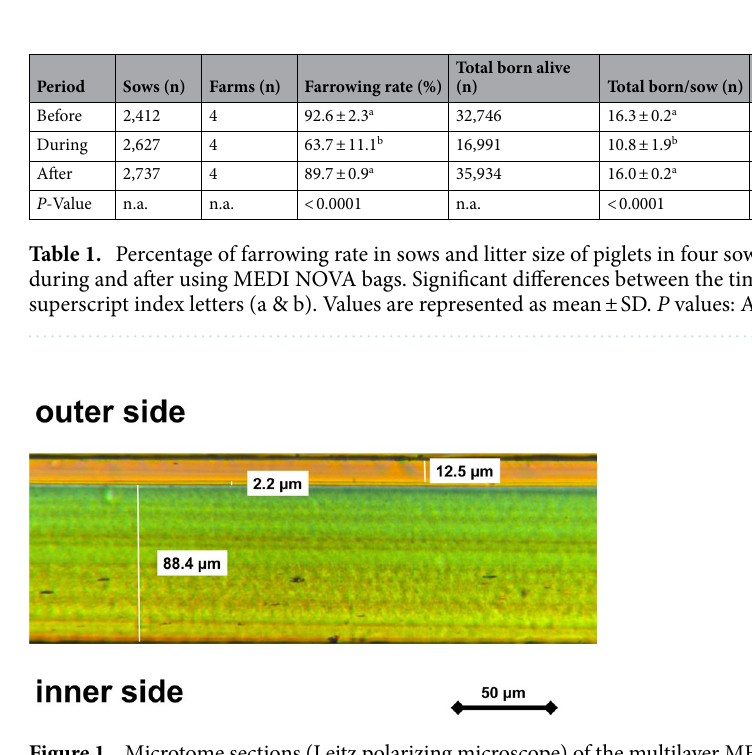
Figure 1. Microtome sections (Leitz polarizing microscope) of the multilayer MEDI NOVA bag. The adhesive layer is 2.2 µm wide. Underneath is the inner thinner layer (88.4 µm) that comes into contact with the extended semen. The outer layer is 12.5 µm wide ( Source Fraunhofer Institute for Process Engineering and Packaging, Freising,